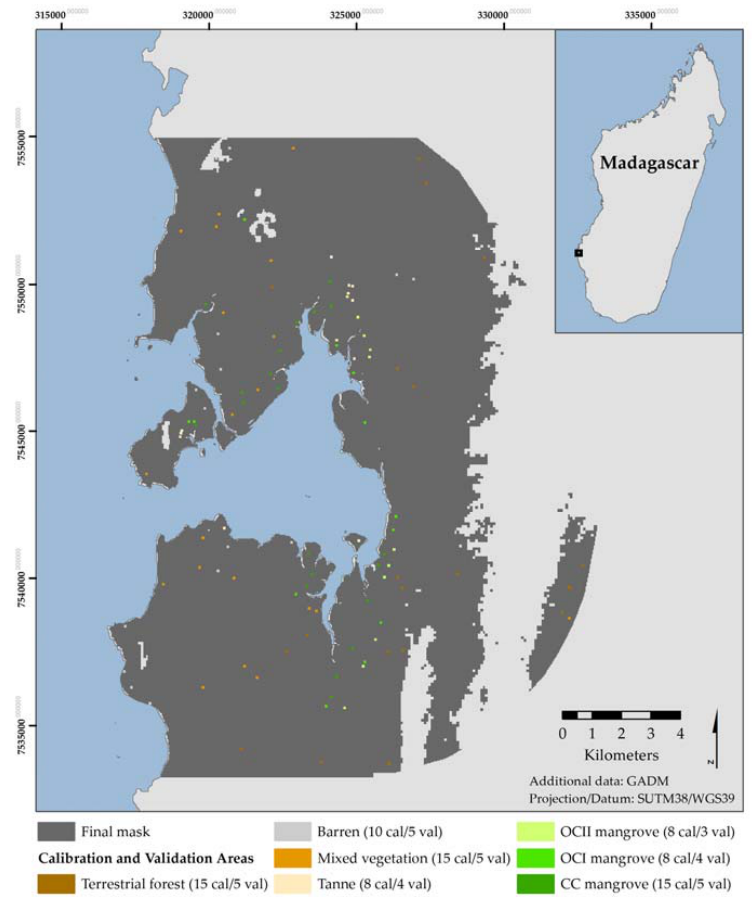
Figure 4. The finalized mask used to subset the Landsat data in order to exclude areas more than 7 km from the coast, elevations of greater than 30 m above mean sea level and inundated areas. Also shown are the 3 × 3 pixel calibration and validation areas used to train and test the maximum likelihood classification algorithm. The numbers in brackets indicate number of calibration (cal) and validation (val) areas for each class.